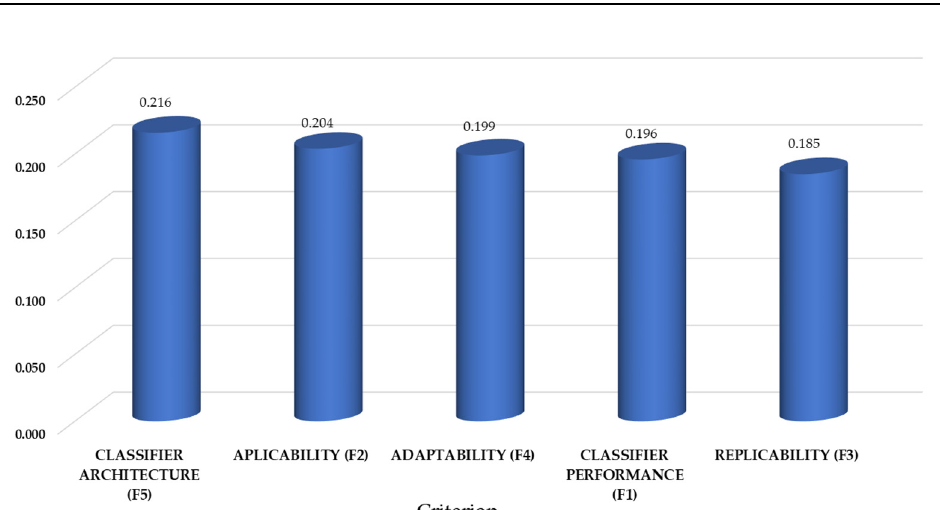
Figure 3. Ranking of classifier selection criteria.